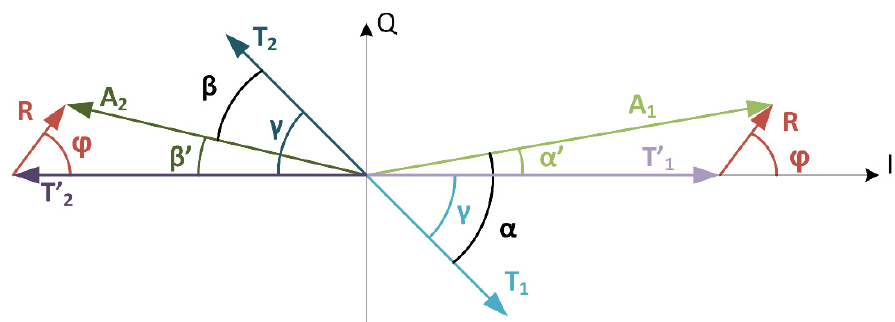
Figure 7. Phasors representing the voltages on the tag antenna during ALM transmission.